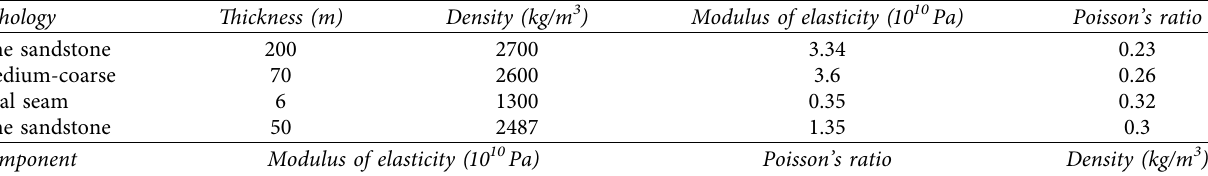
Figure 2: Initial model diagram. Table 2: Material parameters of rock.